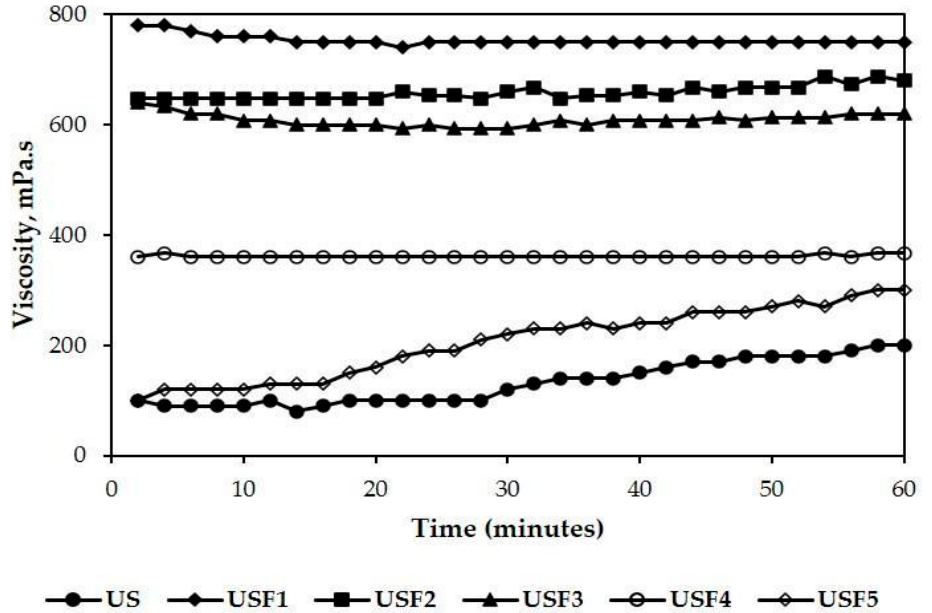
Figure 5. A plot of viscosity with time at 14.2 s − 1 (100 rpm for pure NMW slip) and 21.4 s − 1 (30 rpm for formulated NMW slips); 29.5 °C.